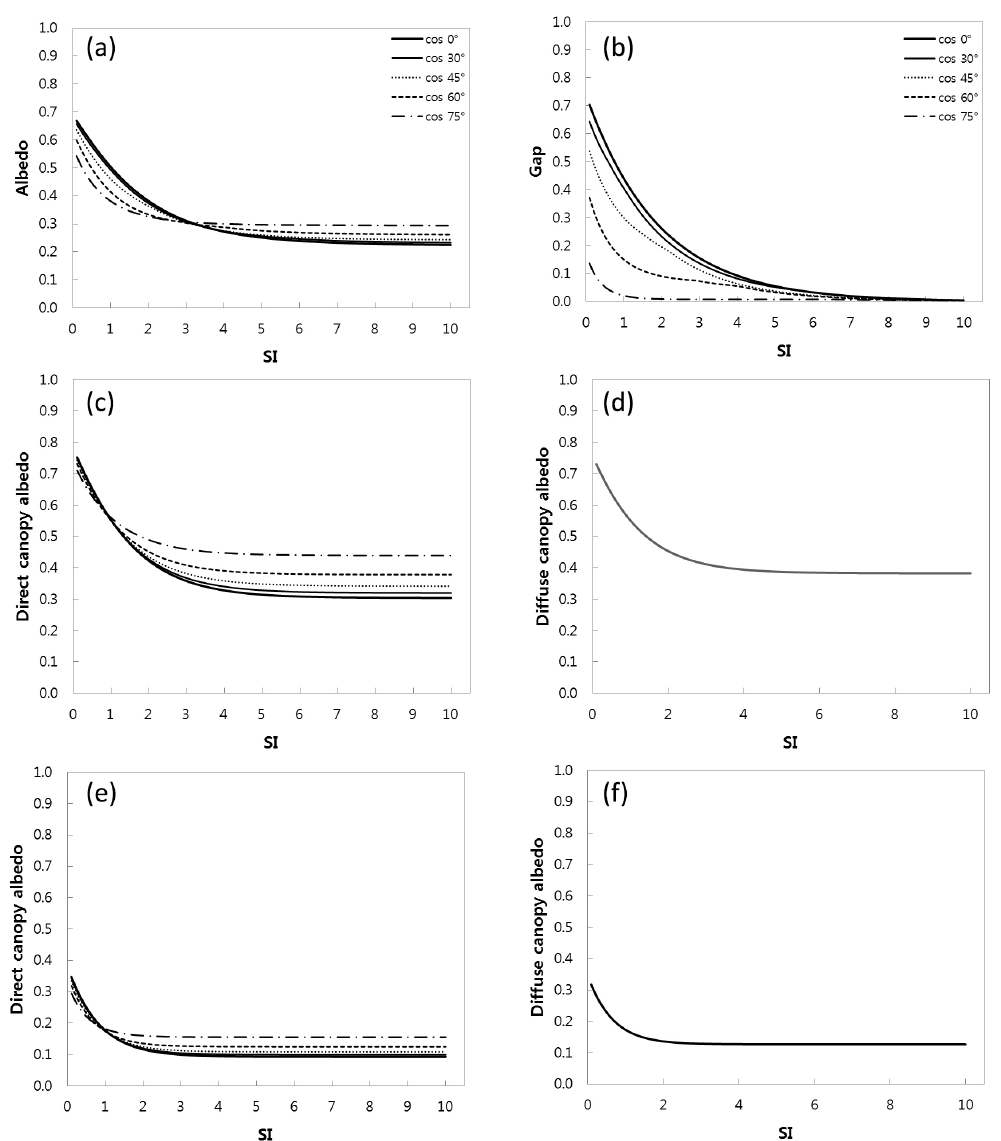
Figure 5. Sensitivity of the snow-covered surface albedo and each term in the albedo equation in the Noah-MP to SI averaged over four forest types: (a) total albedo, (b) canopy gap probability, (c) direct albedo and (d) diffuse albedo for visible broadband, and (e) direct albedo and (f) diffuse albedo for near-infrared